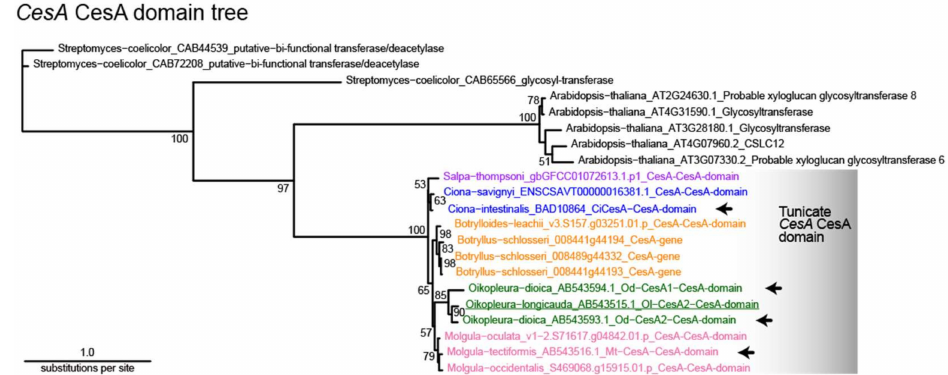
Figure 2. Molecular phylogenic tree of the CesA domain obtained using ORTHOSCOPE analysis (884 nucleotide sites). The CesA domains of four CesA genes from three tunicates (indicated with arrows) were used as query sequences. The Streptomyces sequence (CAB44539) was selected for tree rooting. Because all the non-tunicate metazoans examined did not contain CesA orthologs, the tree includes those of Streptomyces and Arabidopsis in addition to tunicates. The numbers beside the nodes indicate bootstrap probabilities ( > 50%). To count orthologs, identical sequences derived from ORTHOSCOPE were replaced with query sequences. Sequences ending with “-gene” are raw data, whereas those ending with “-domain” are partial gene sequences. Color coding for taxonomic groupings is used in the other figures. Underlined sequences were manually added to the sequence alignment.